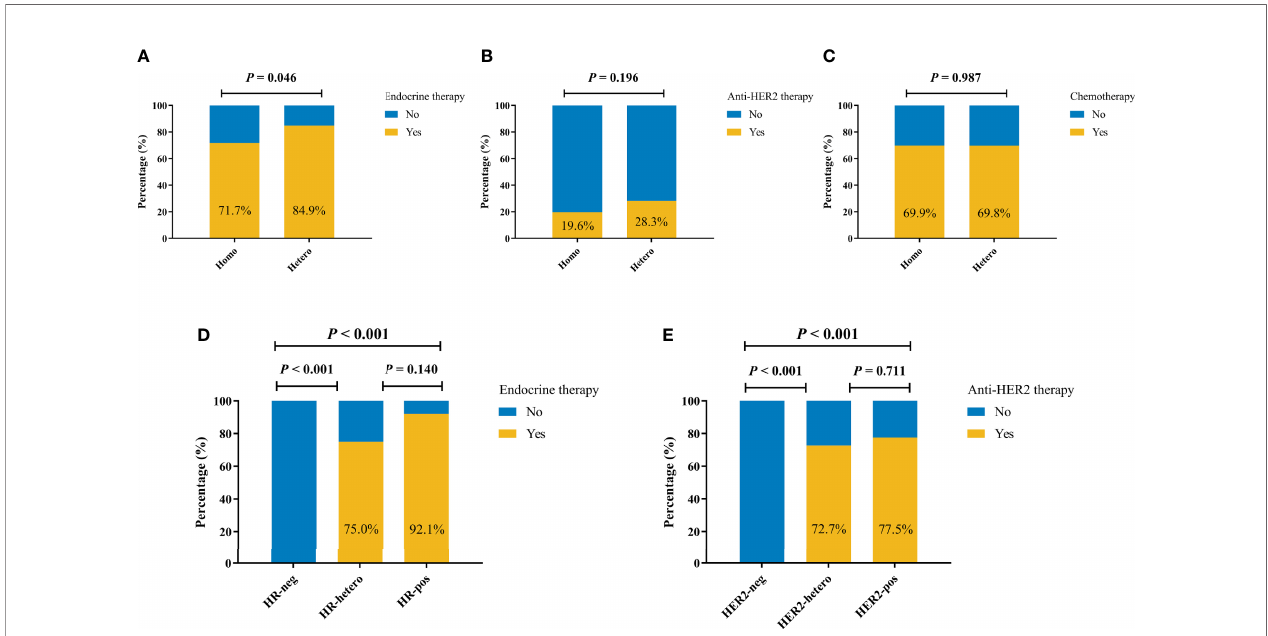
FIGURE 2 | Adjuvant systemic therapybymolecular markersstatusamong330 patients with atleast two invasivetumor foci.Adjuvant endocrine therapy (A) , anti-HER2 therapy (B) , andchemotherapy (C) by molecular markersstatus. (D) Adjuvant endocrine therapy byHR status. (E) Adjuvant anti-HER2 therapy byHER2 status.